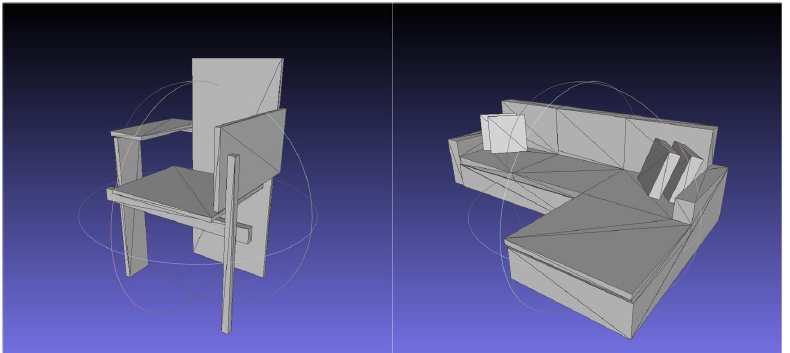
Figure 1. Face-based 3D